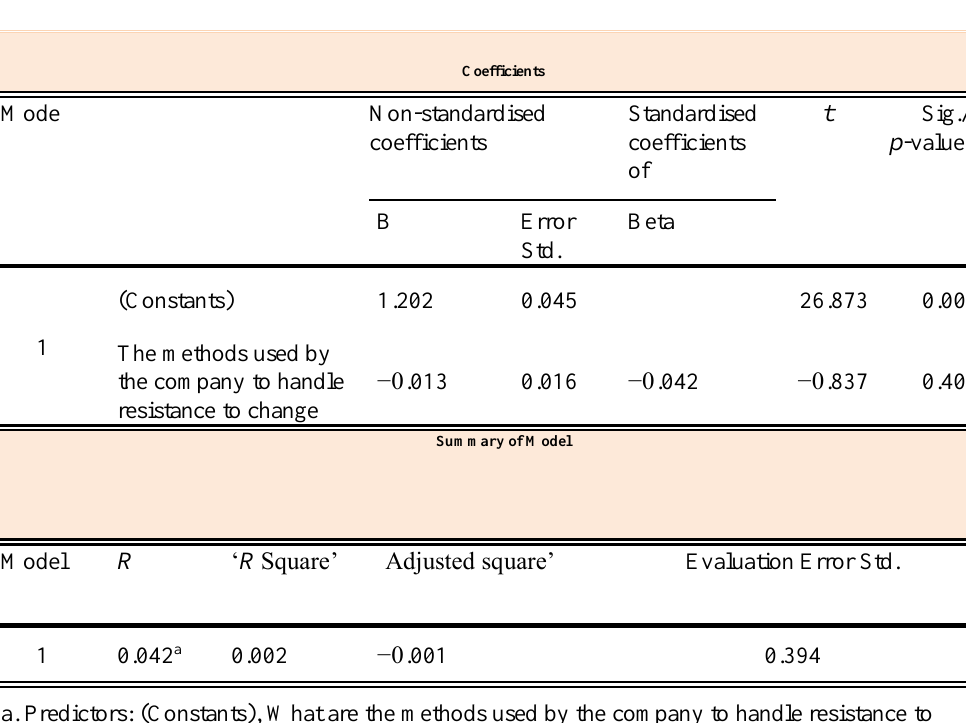
Table 1. The Methods to Handle Resistance to Change (developed by the